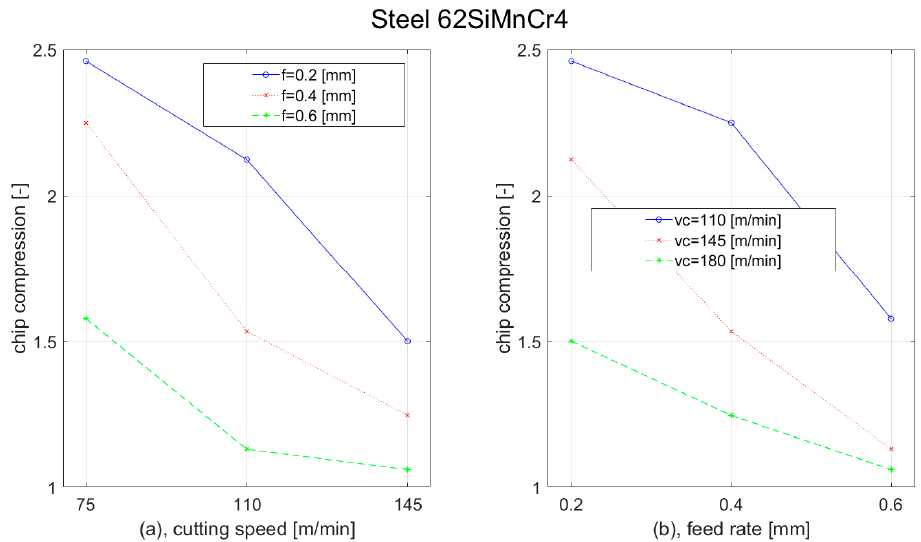
Figure 13. Graph of chip compression dependence of Steel 62SiMnCr4 on: ( a ) cutting speed; ( b ) feed rate. ( b ) feed